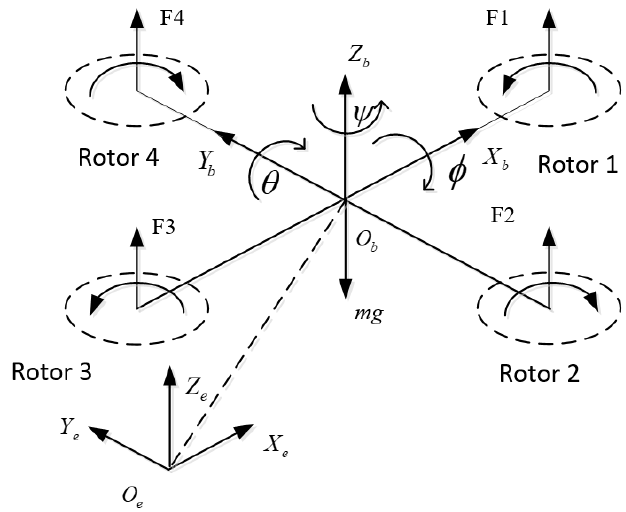
Figure 1. Force analysis diagram of QUAV.